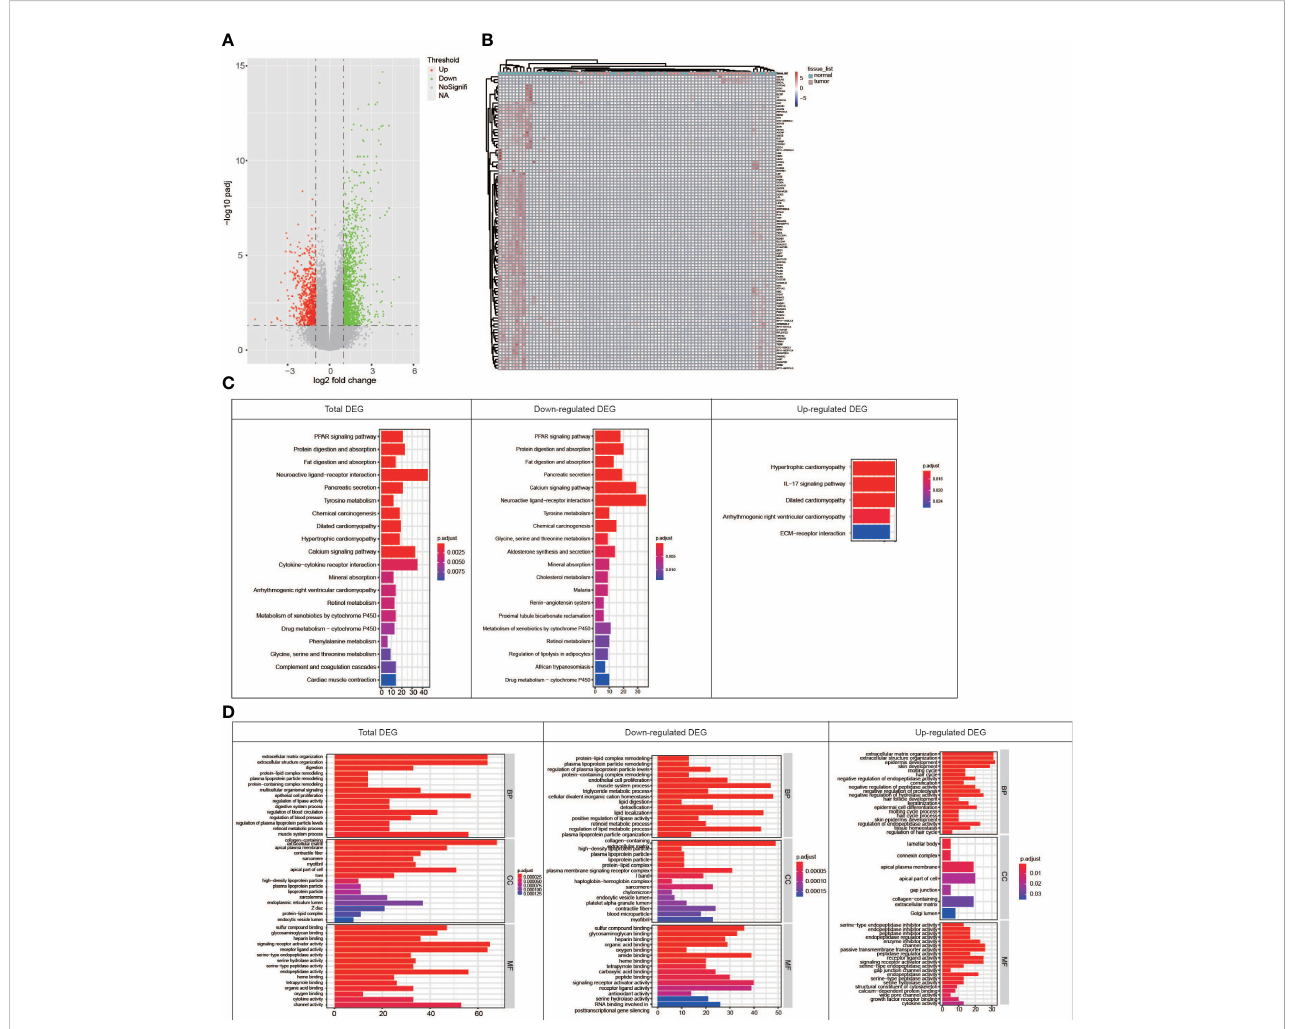
FIGURE 4 Comparison of the RNA expression between paired tumor and normal samples. (A) Volcano map showing genes with different RNA expressions between tumor and normal groups. (B) Heat map showing that top 100 DEGs can distinguish normal tissues from tumors well. (C) KEGG pathway enrichment for DEGs in total, downregulated, and upregulated patterns. (D) GO term enrichment for genes in total, downregulated, and upregulated